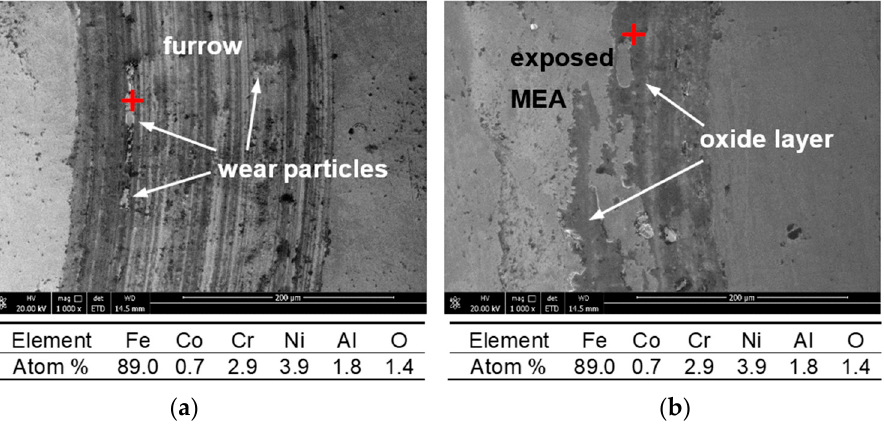
Figure 10. EDS analysis for wear tracks of coatings: ( a ) tested at RT (10 N); ( b ) tested at 573 K (10 N).